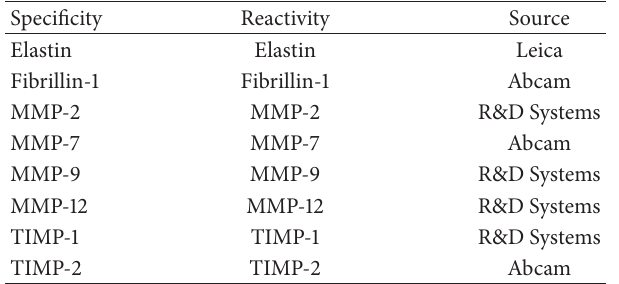
Table 1: Primary antibodies used in the study. Table 2: Demographic information of 30 anetoderma patients according to clinical